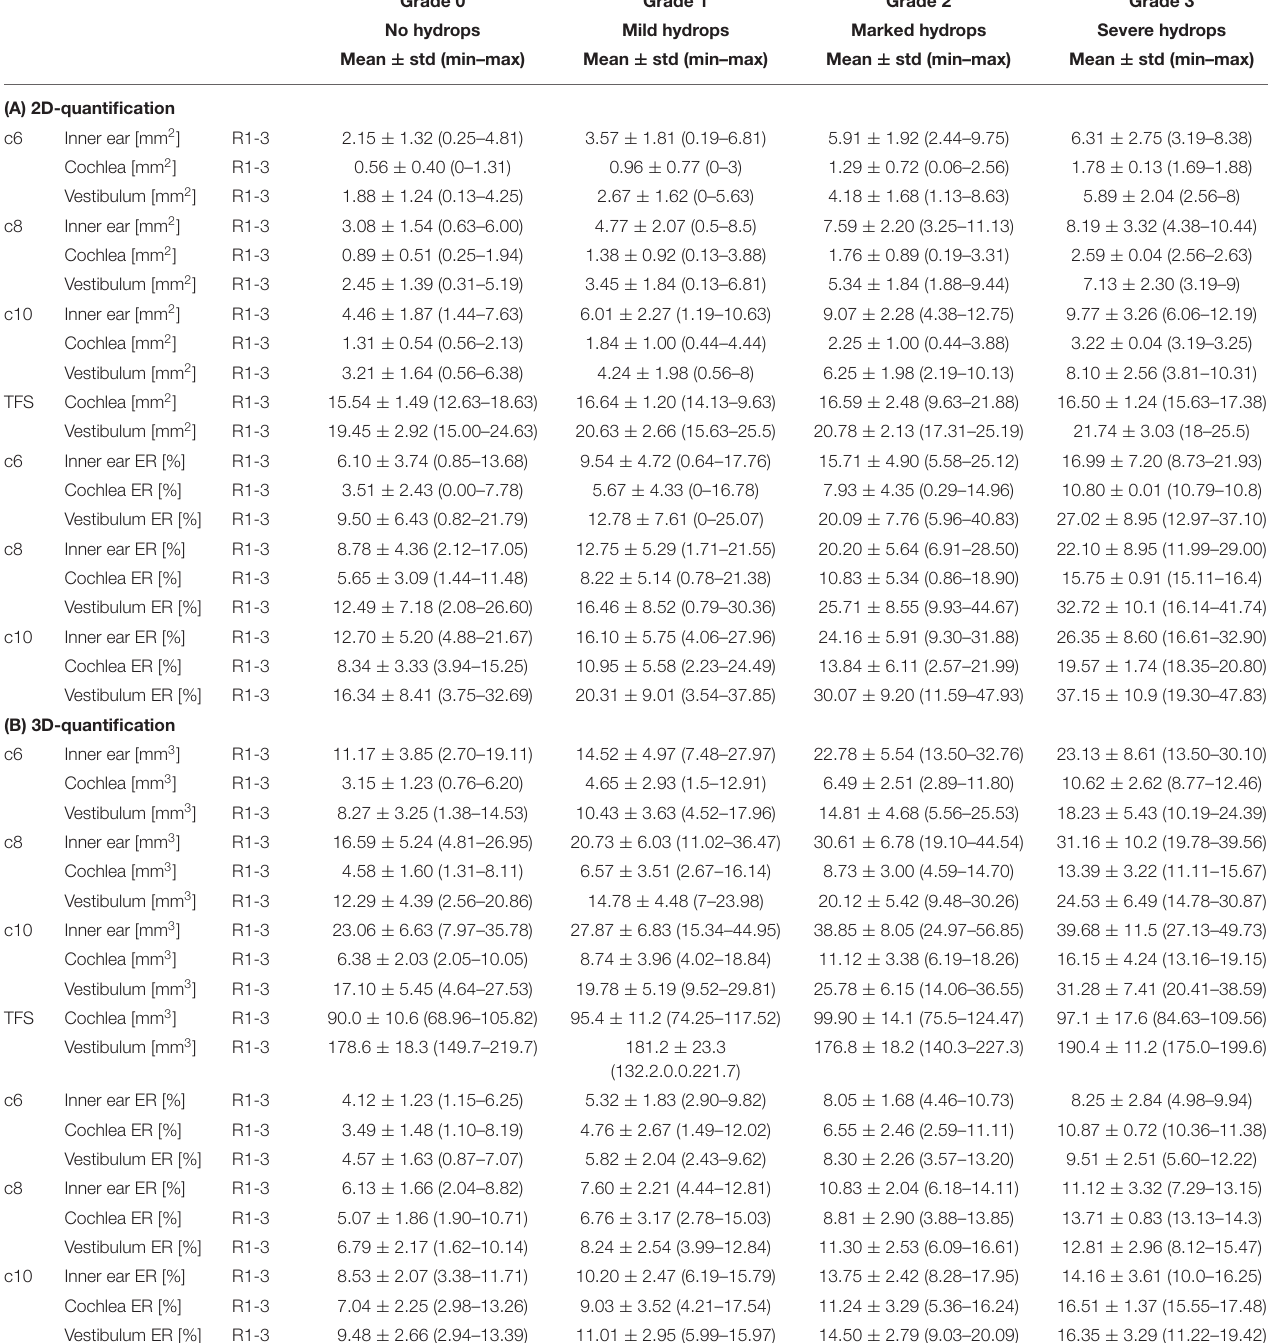
TABLE 5 | SQ-specific 2D- and 3D-quantification of the